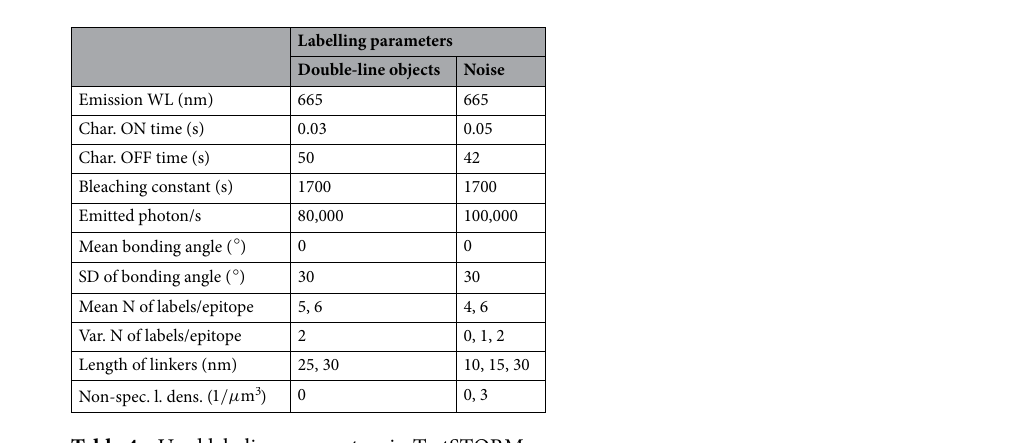
Table 4. Used labeling parameters in TestSTORM.